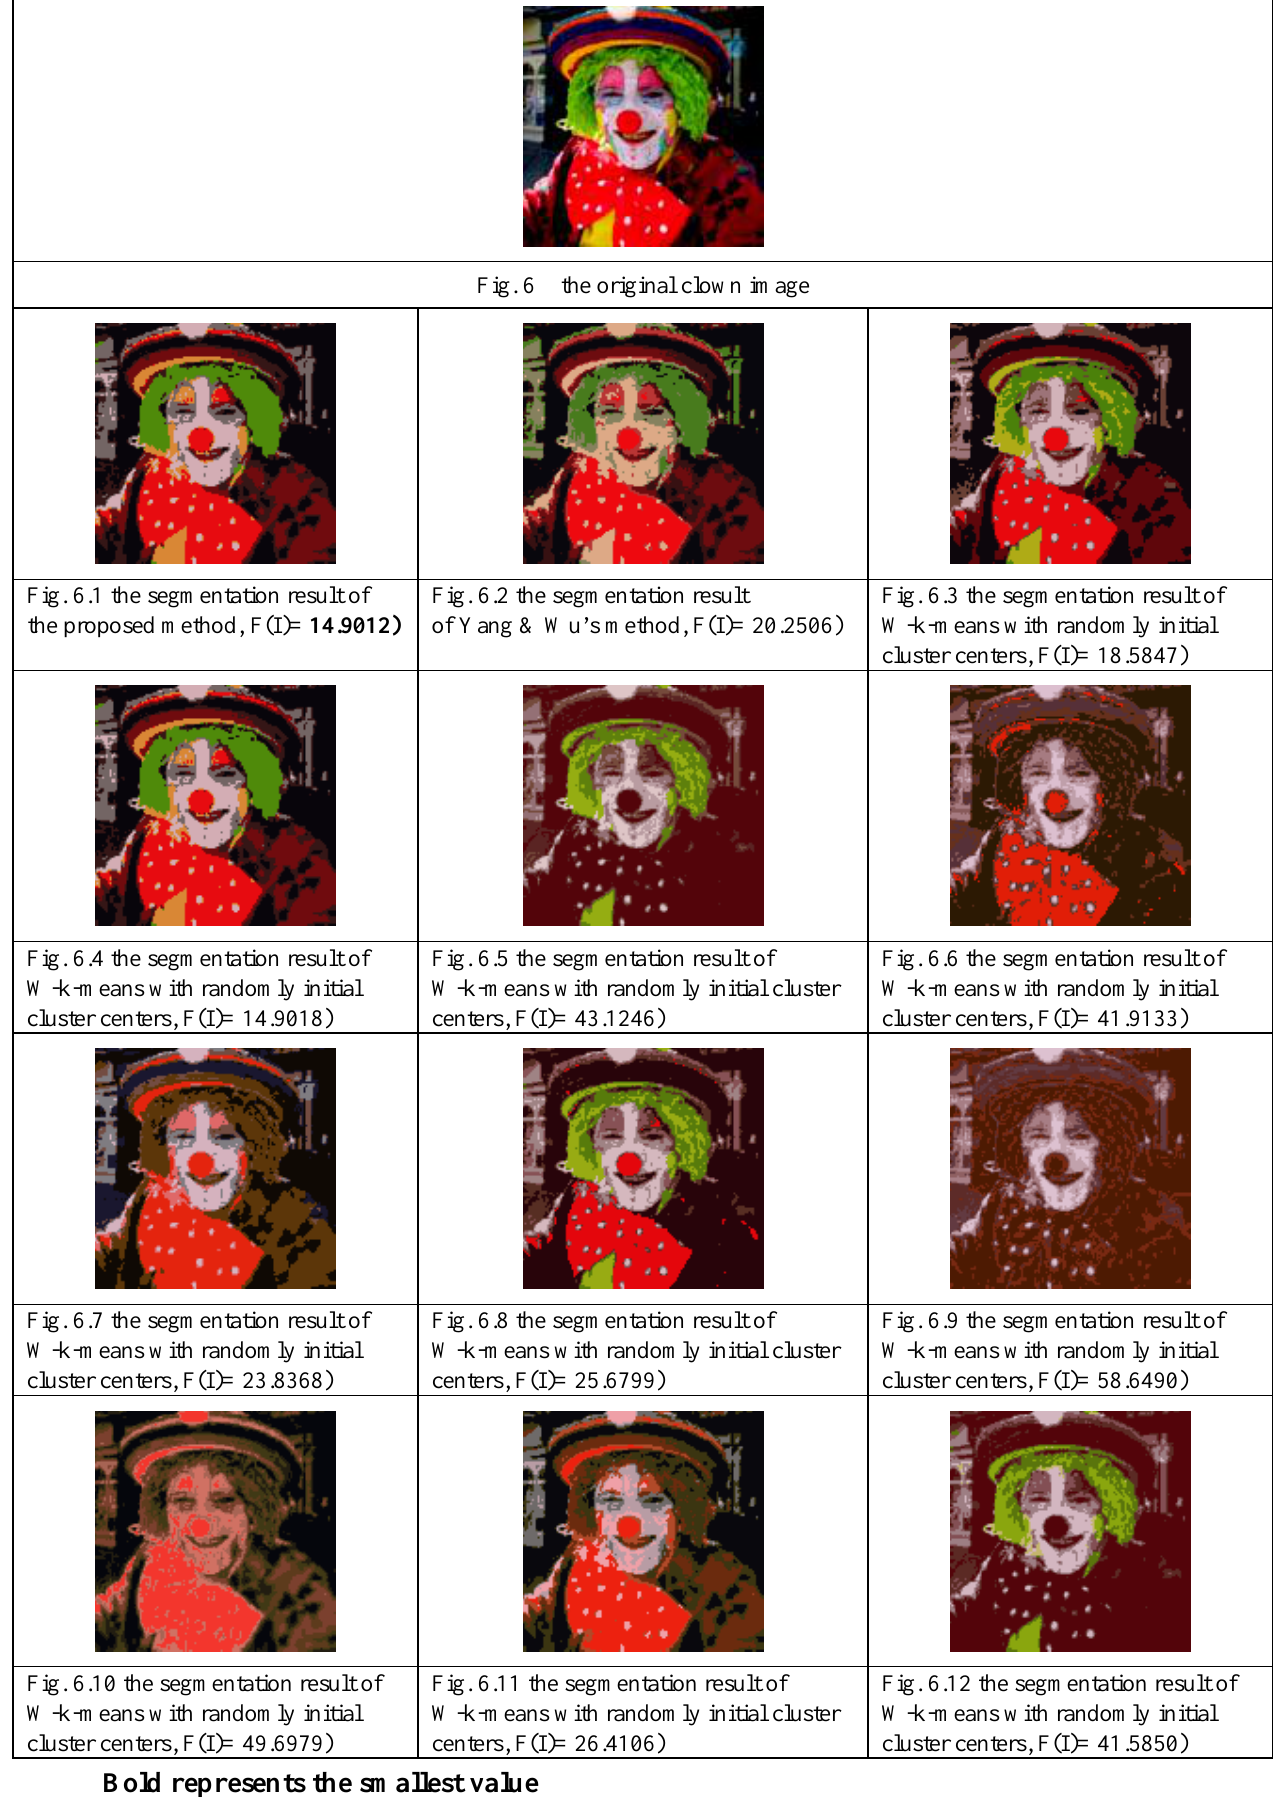
Fig. 6.12 the segmentation result of W-k-means with randomly initial cluster centers, F(I)=